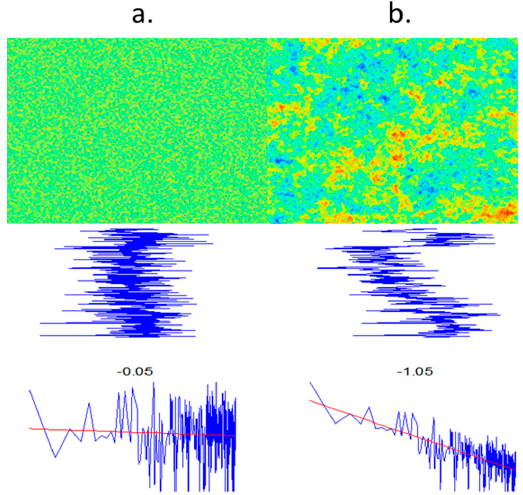
Figure 6. ( a ): Spatially uncorrelated and ( b ) correlated hypothetical porosity models. ( Top ): Map views of porosity variation indicated by color. ( Middle ) Representative synthetic porosity well-logs in an arbitrary direction through the porosity map view images above. The ordinate is distance and the abscissa is the magnitude of porosity. ( Bottom ): Power spectrum of synthetic well-log porosity, plotting the square of harmonic amplitude (ordinate) against spatial frequency (cycles per km) on abscissa. Numbers are the power exponents (- β ) of the power spectra (see Equation (4)). They confirm that the left map distribution is spatially uncorrelated white noise ( β ~ 0) and the right map distribution is spatially correlated 1/ k pink noise ( β ~ 1).